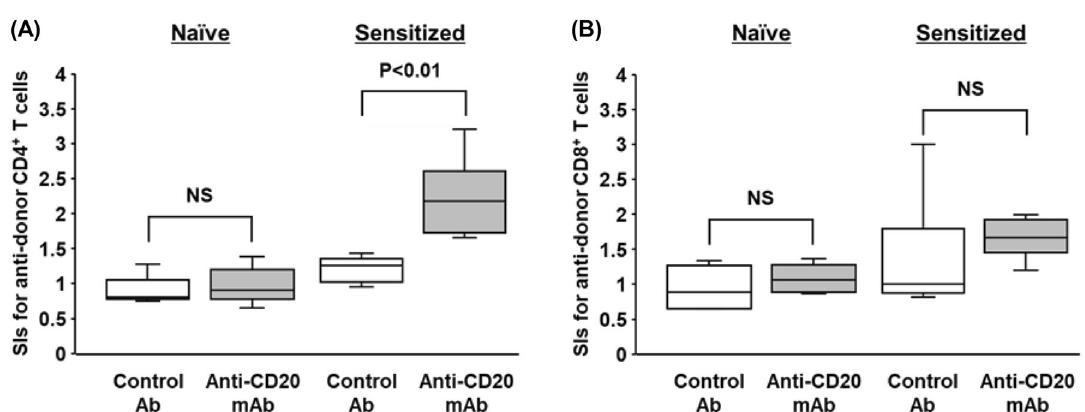
Figure 3. Anti-donor T cell immune responses after B cell depletion with anti-CD20 mAb in a murine model. One week after administration of either anti-CD20 mAb or isotype-matched control antibodies (control group) to either naïve mice or sensitized mice, CFSE-MLR assays were performed to evaluate anti-donor T cell responses. The SI values of each of the CD4 + T cell ( A ) and CD8 + T cell ( B ) for anti-donor responses are shown. White box, control group; gray box, anti-CD20 mAb group. Data from five independent experiments are shown as median, 25th and 75th percentiles, and range. The Wilcoxon-Mann–Whitney test was used to evaluate differences between the control and anti-CD20 mAb